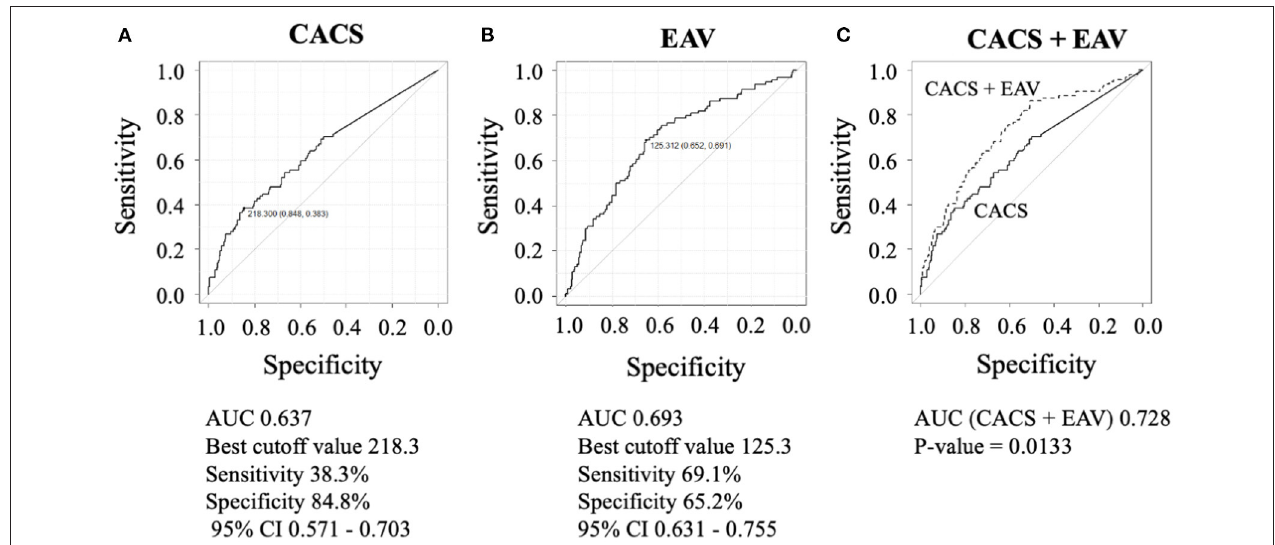
FIGURE 4 | To diagnose patients with %LAP (Q4), the ROC analysis demonstrated that the best cut-off value for CACS was 218.3 Agatston units (A) , and that for EAV was 125.3 ml (B) . (C) Addition of EAV on CACS significantly improved the AUC that is used to identify %LAP (Q4) than CACS alone (C, EAV + CACS versus CACS alone, 0.728 versus 0.637; p =